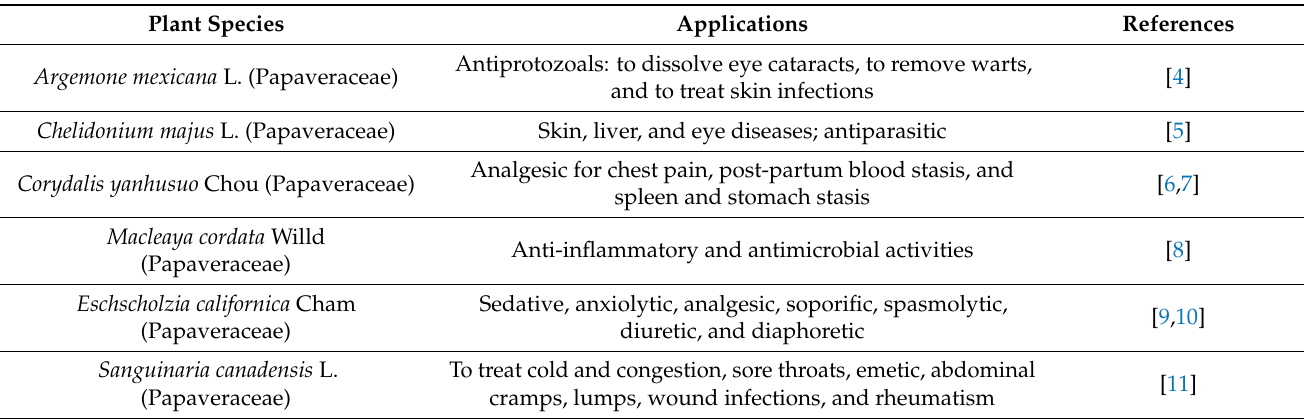
Table 1. A few plants bearing BZD alkaloids and their traditional medicinal uses. Plant species Applications